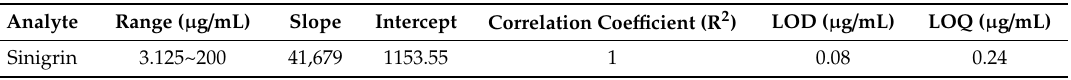
Table 6. Correlation coe ffi cient of the calibration curves, LOD 1 and LOQ 2 of sinigrin analysis. Analyte Range ( µ g / mL)